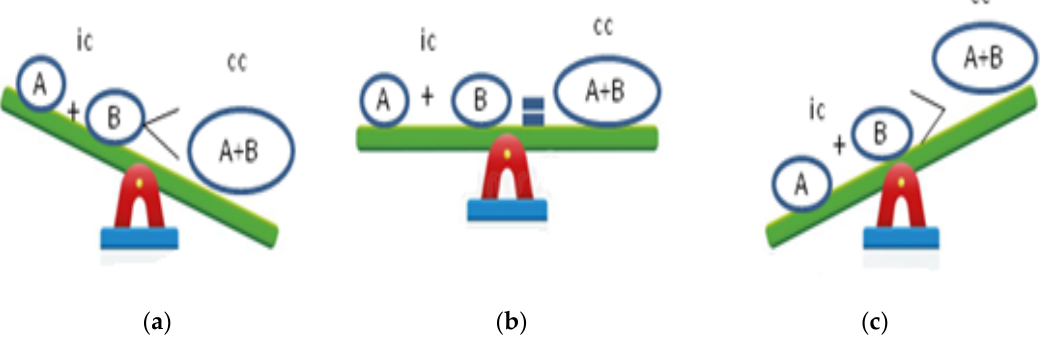
Figure 1. Combination effects of bioactive compounds: ( a ) synergistic effect; ( b ) additive effect; ( c ) antagonistic effect; ic: individual compounds; cc: combined compound.